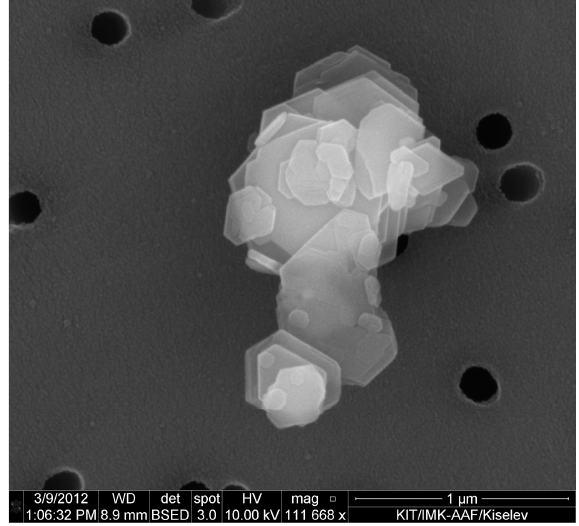
Fig. 1. SEM image of the typical agglomerate structure of a kaolin- ite KGa-1b particle on a nuclepore filter.